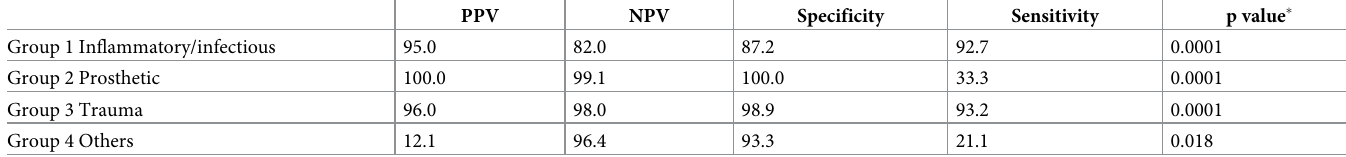
Table 3. Predictive values, sensitivity, and specificity of prediagnosis at the triage level versus clinical diagnosis in children (%).